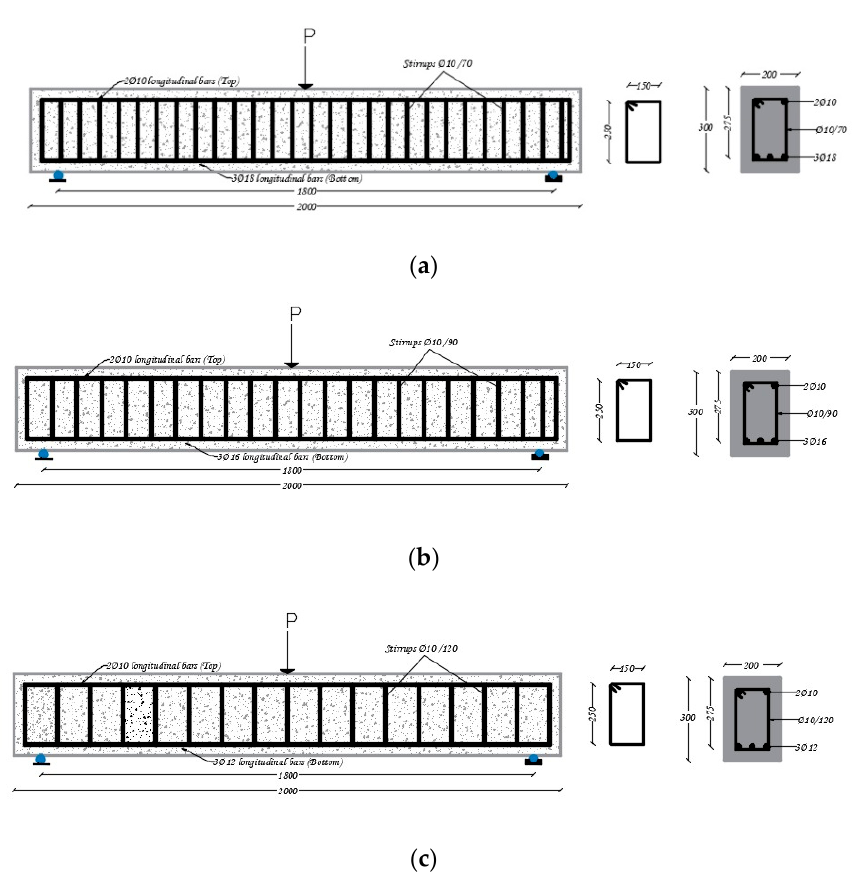
Figure 2. Reinforcement detailing of the three groups tested (all dimensions are in mm). ( a ) High Concrete Strength (Group H). ( b ) Medium Concrete Strength (Group M). ( c ) Low Concrete Strength (Group L).